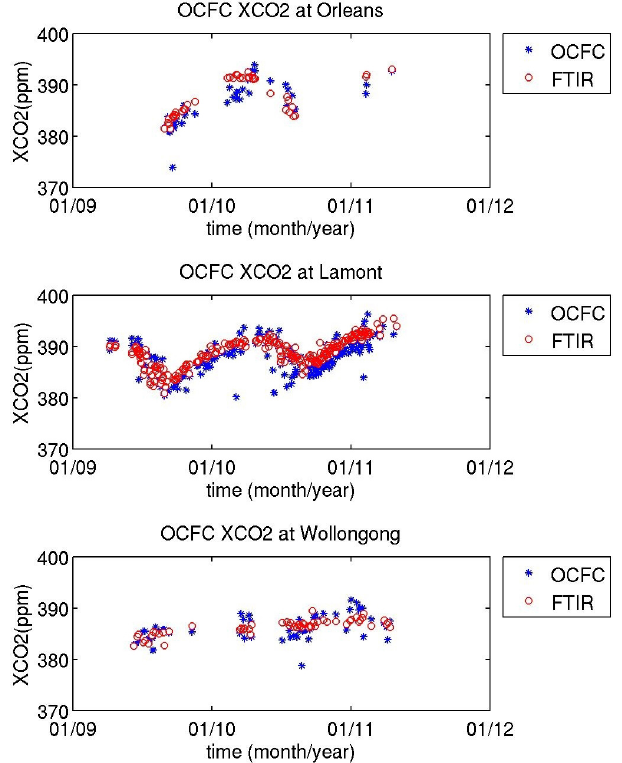
Figure 8. Daily averaged time series of paired SRFC and TCCON FTIR XCO 2 at Orleans (top), Lamont (mid) and Wollongong (bot-